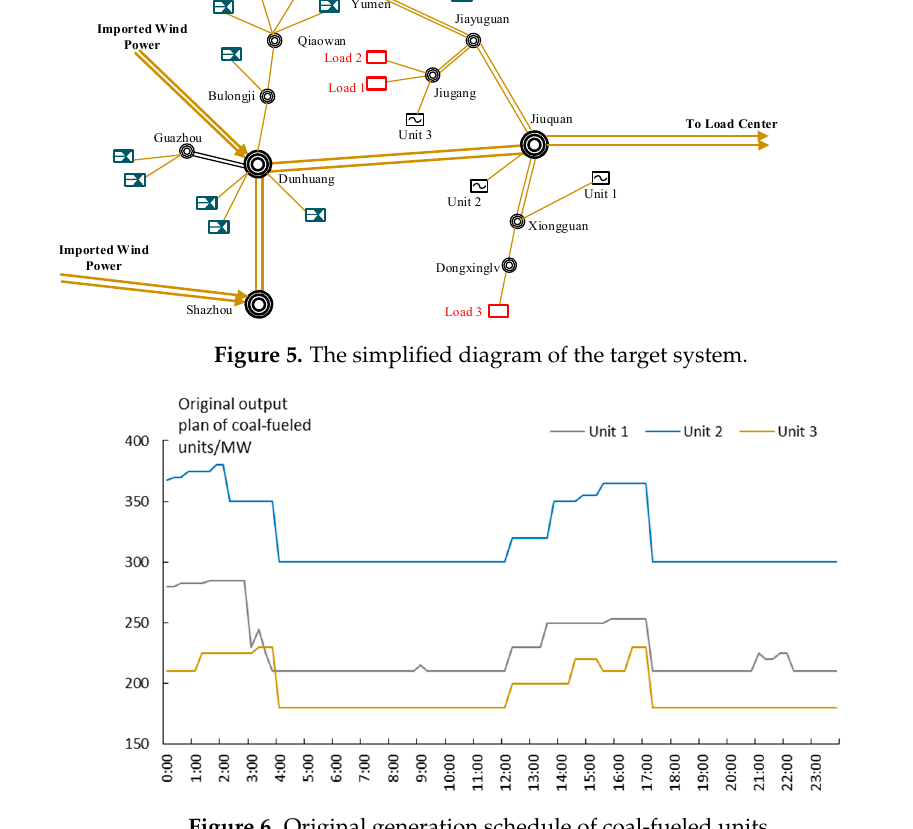
Figure 6. Original generation schedule of coal-fueled units. Table 1. Parameters of coal-fueled units.